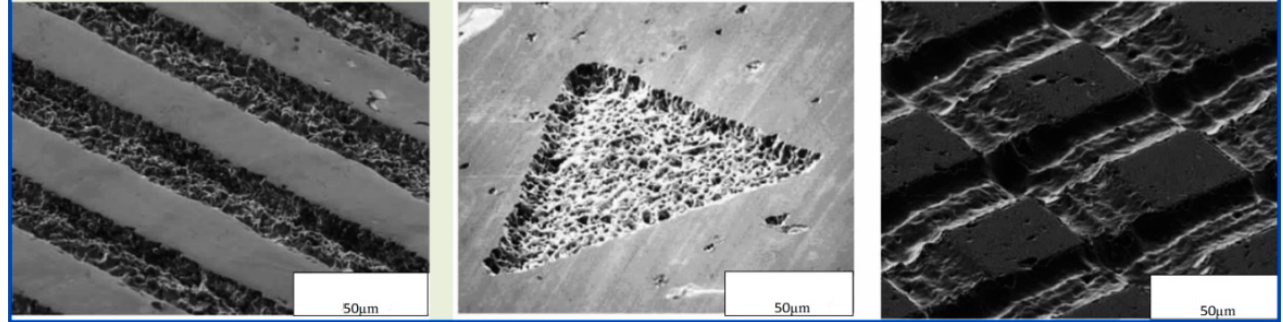
Figure 2. Bionic micro-textured surface.